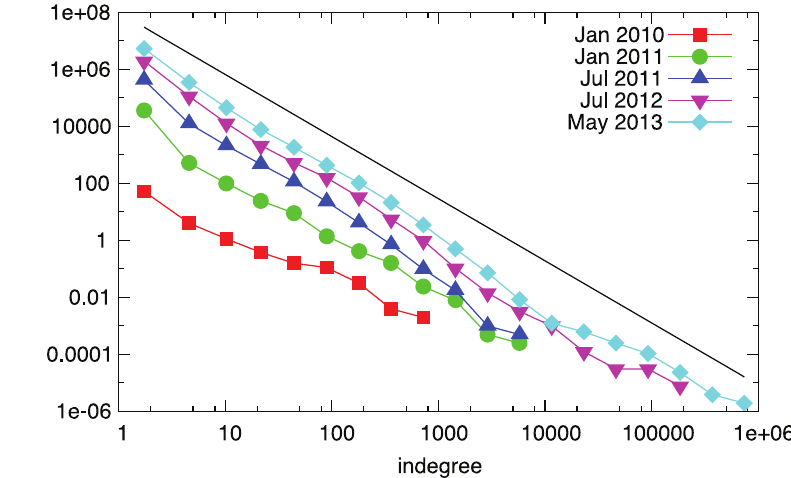
Figure 2. Evolution of the indegree distribution. Since the beginning of 2011, the shape of the distribution does not change significantly. The black line shows a fitted power-law for the final network; the exponent is 2 : 18 . The data is log-binned for ease of visual inspection, the power-law is fitted on the original data [18].